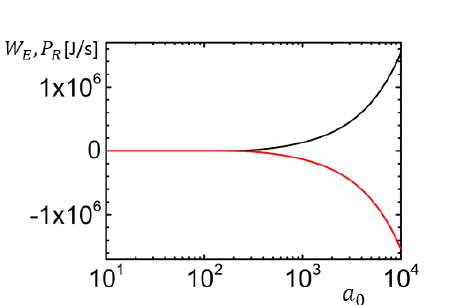
Figure 2. The work rate of the electron done by the electric field W K (black) and the radiation power P R (red) in units of J/s are plotted as functions of a 0 .